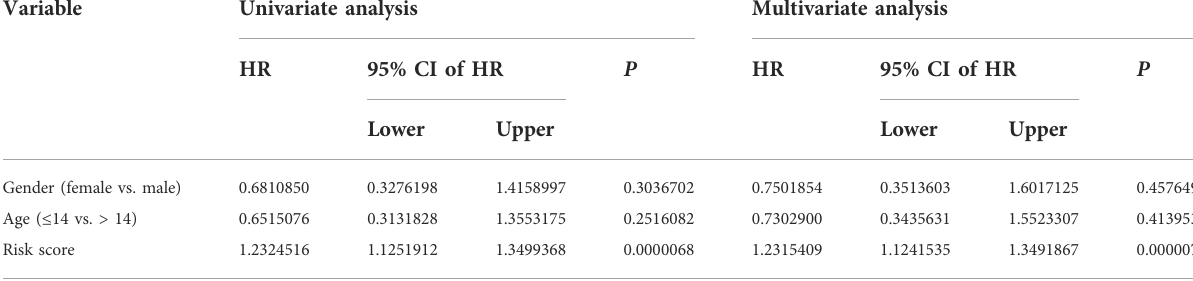
Gender (female vs. male)